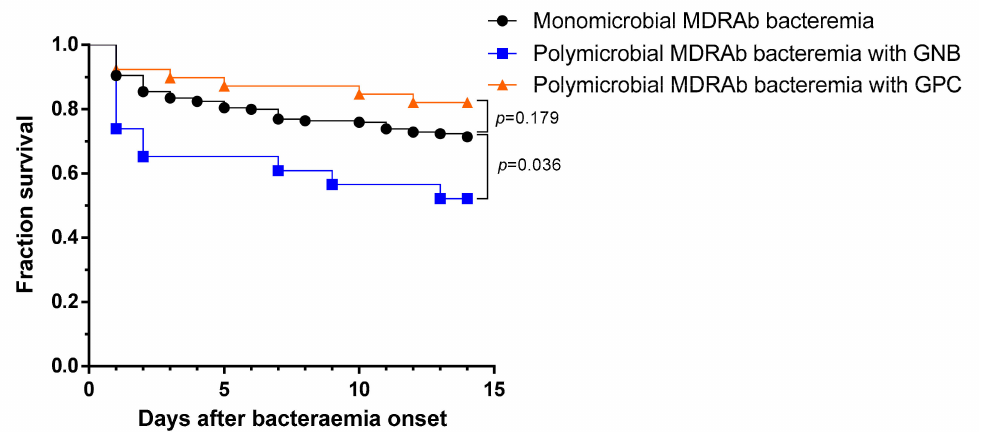
Figure 2. Kaplan–Meier plot showing the survival rates of patients with acquired polymicrobial multidrug-resistant Acinetobacter baumannii (MDRAb) bacteremia with concomitant Gram-negative bacilli (GNB), polymicrobial Ab bacteremia with concomitant Gram-positive cocci (GPC), and those with acquired monomicrobial MDRAb bacteremia. p -values were calculated by log-rank tests. (polymicrobial MDRAb bacteremia with concomitant GNB versus polymicrobial MDRAb bacteremia with concomitant GPC, p = 0.009 by log-rank